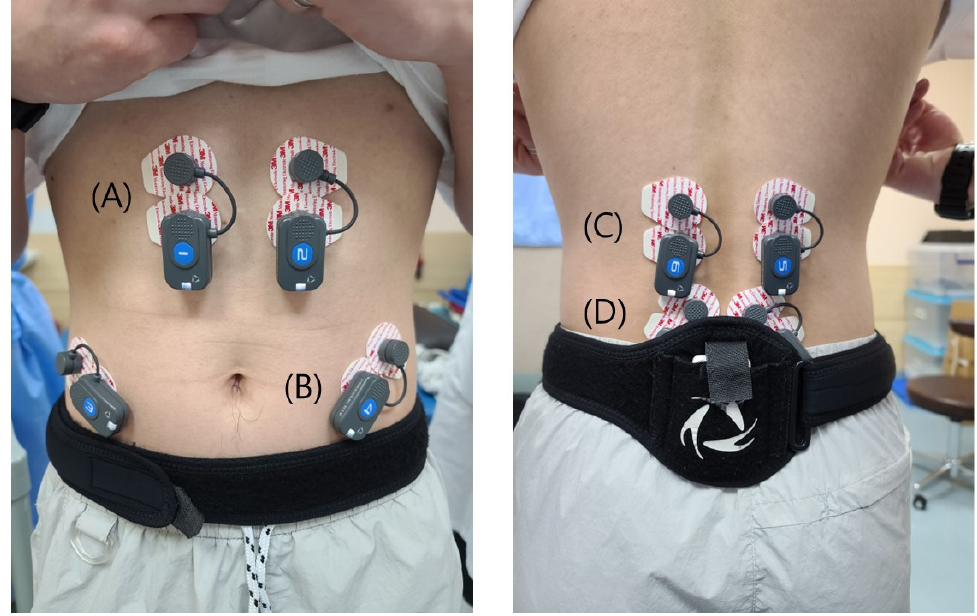
Figure 1. Locations of the placement of electrodes: ( A ) rectus abdominis; ( B ) external oblique. ( C ) lumbar erector spinae. ( D ) superficial lumbar